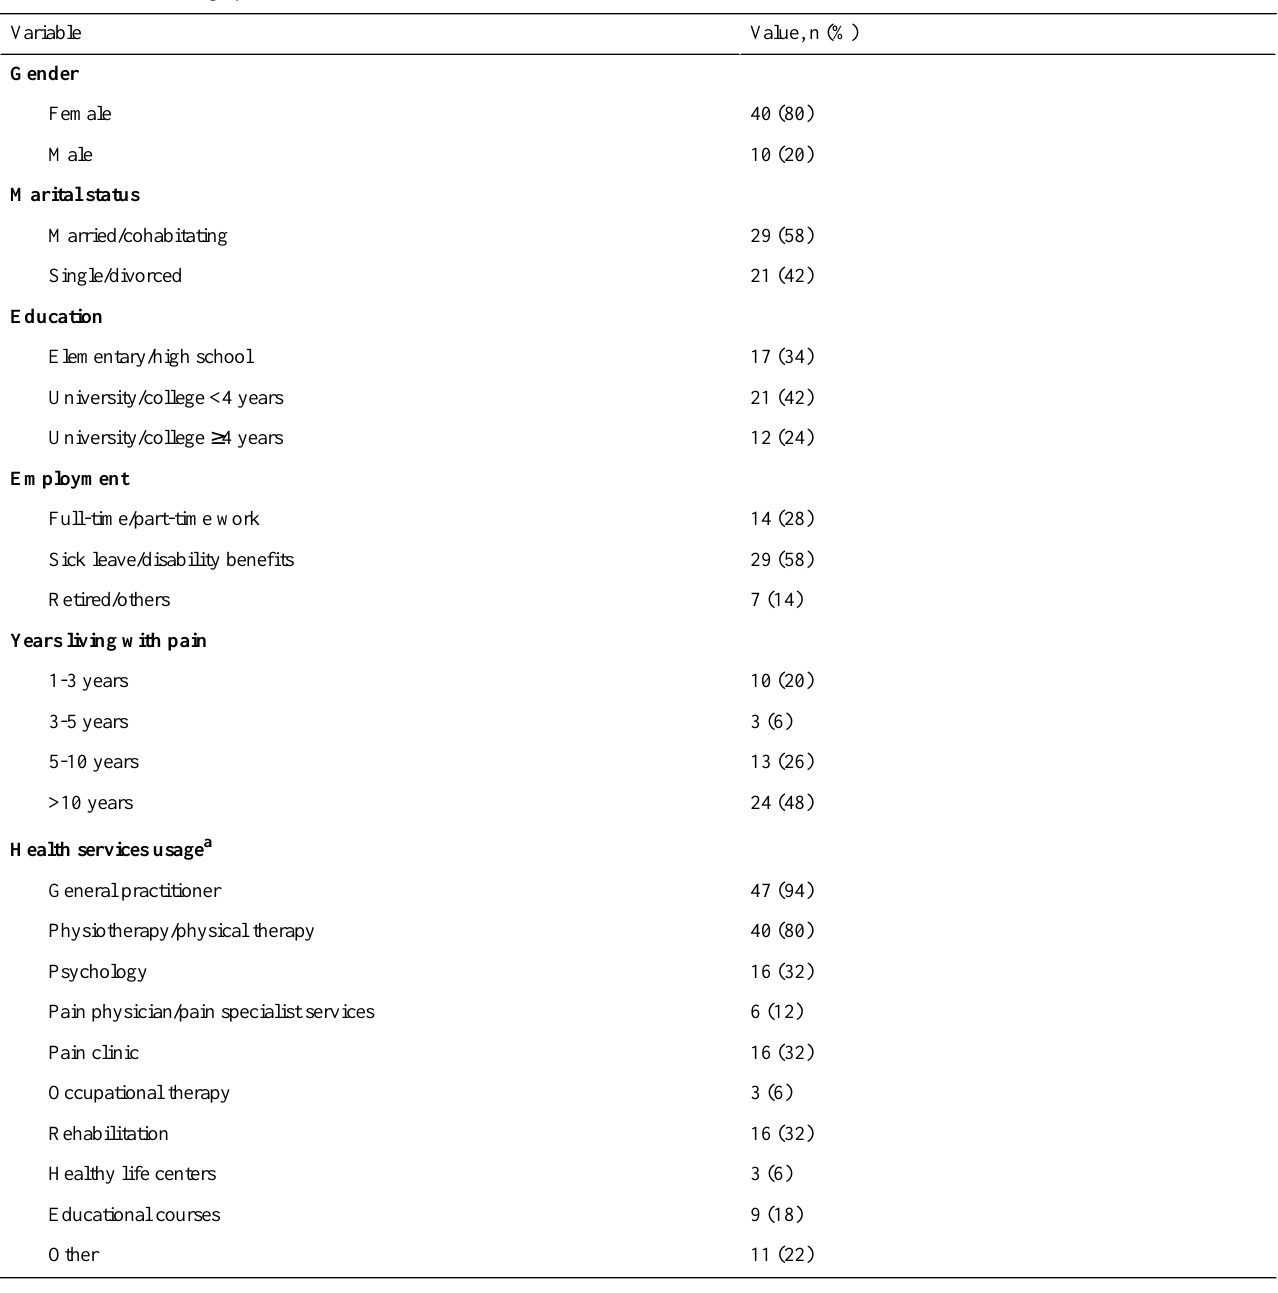
Table 1. Baseline demographics and illness characteristics